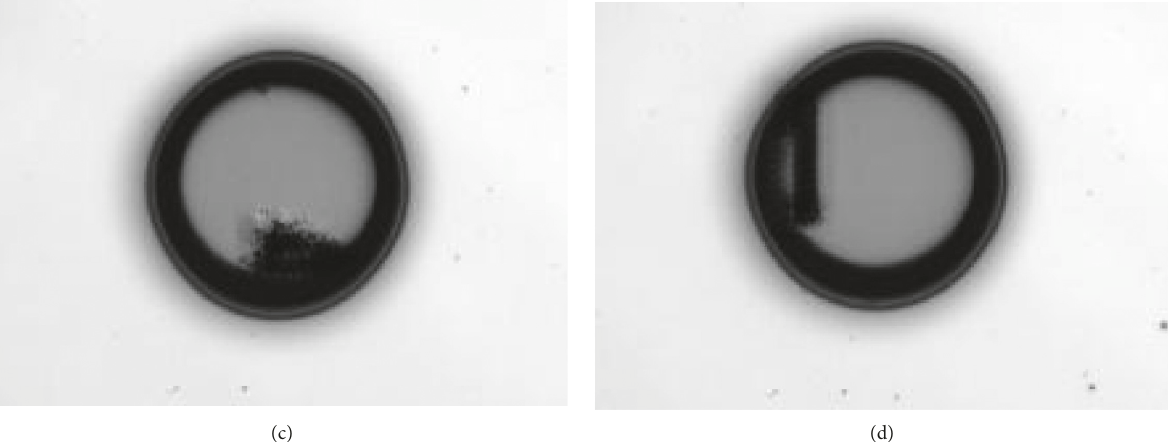
Figure 14: Result of abnormal PSs through CAE.